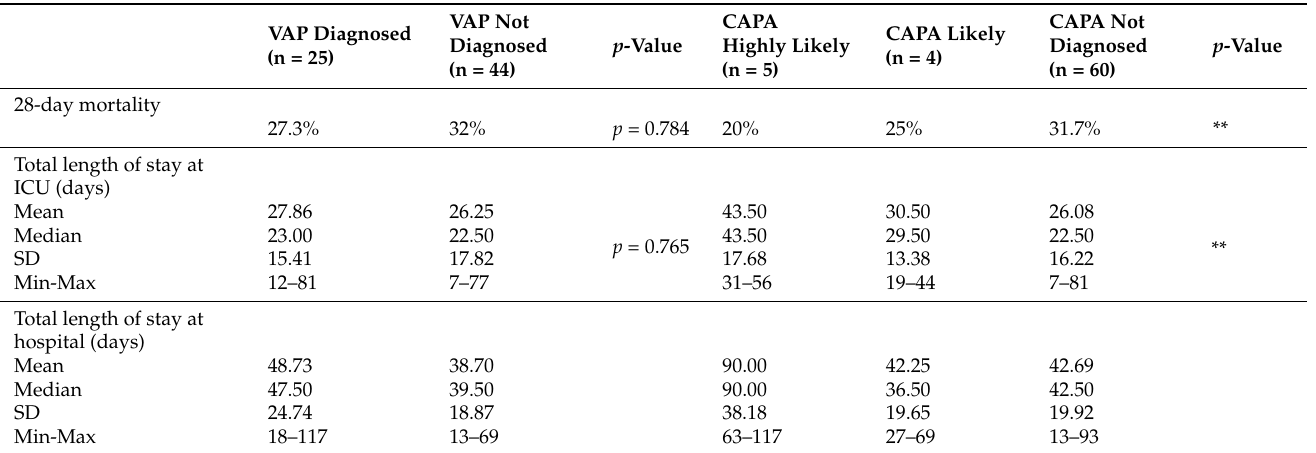
Table 6. Influence of presence of VAP (ventilator-associated pneumonia) or CAPA (COVID-19- associated pulmonary aspergillosis) in 28-day mortality or length of stay at ICU (intensive care unit) and hospital in patients requiring invasive ventilation. ** no p -value available due to low number of